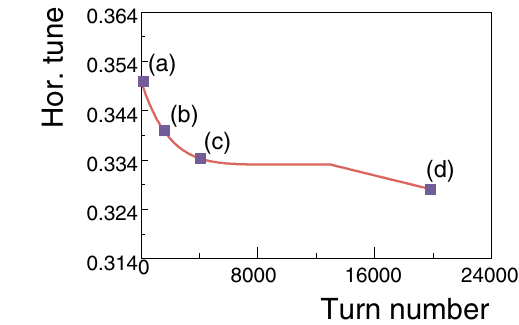
FIG. 3. (Color) Evolution of the tune used for the simulation of a three-turn extraction ( p (cid:1) 7 ). The four points labeled with letters correspond to the tune values at which the beam dis- tribution is shown in Fig. 4.